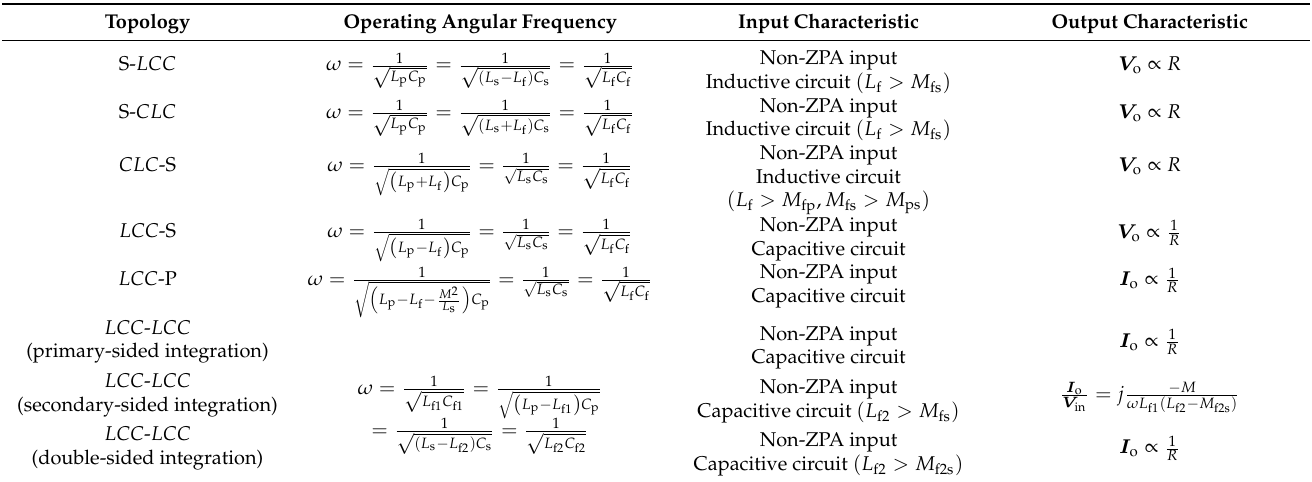
Table 3. Operational characteristics of high-order compensation topologies with extra couplings using conventional resonant calculation